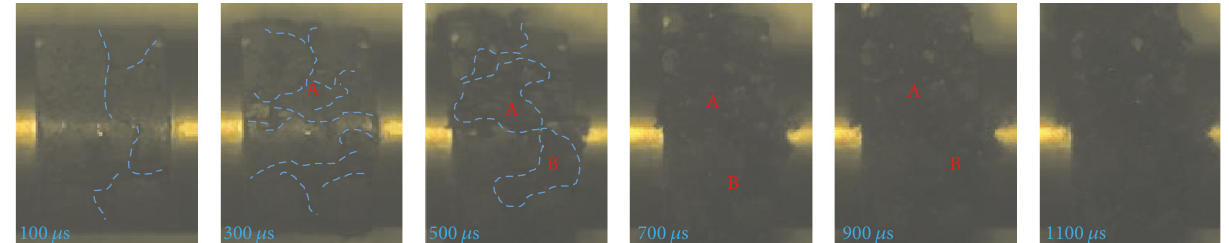
Figure 13: High-speed photos of 7D saturated specimen (B8) in dynamic failure